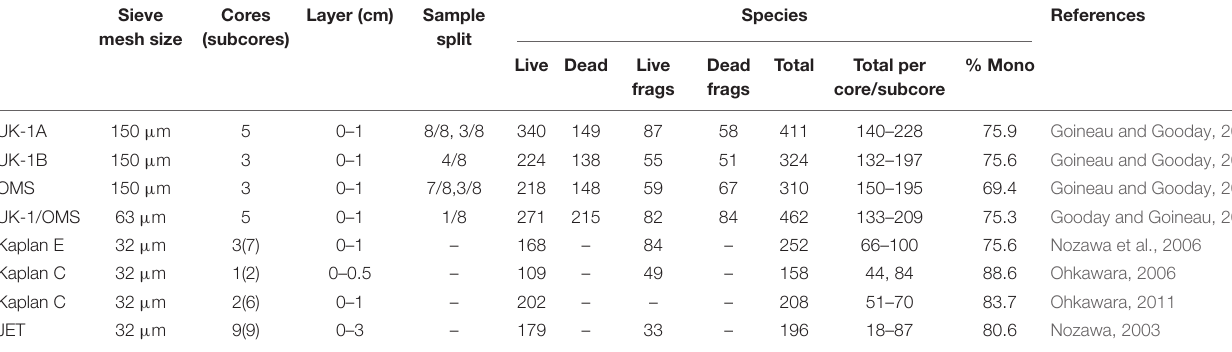
TABLE 2 | Species richness in core samples from the CCZ.